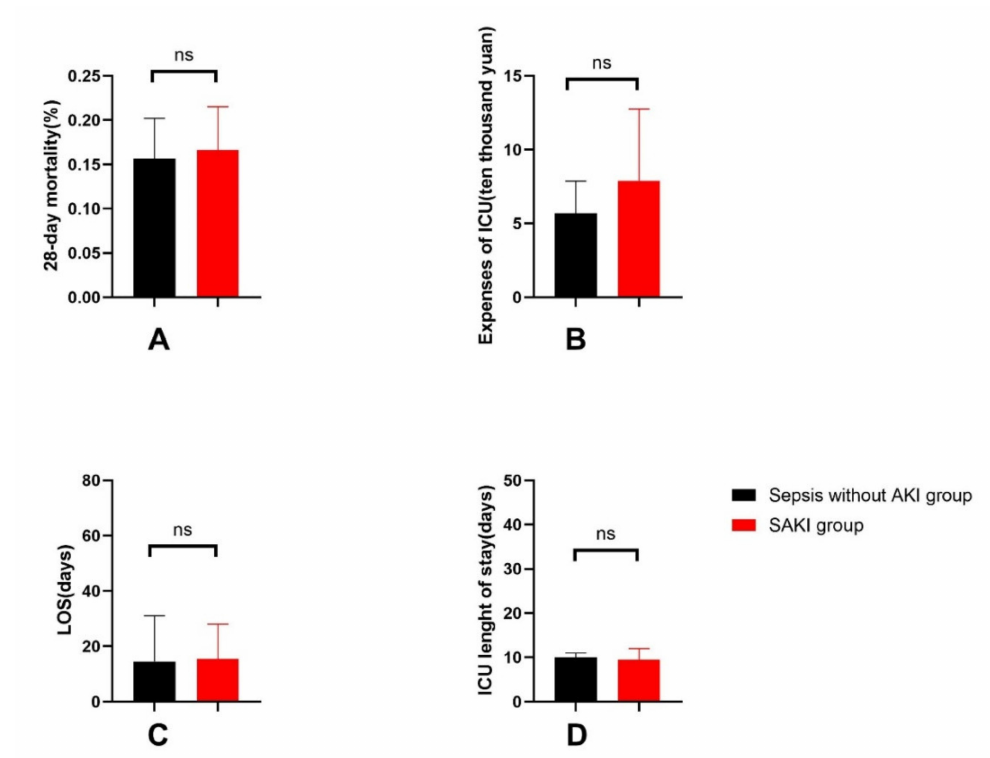
Figure 6. General outcomes between the SAKI group and the sepsis-without-AKI group, including the comparison of 28-day mortality ( A ), expenses of ICU ( B ), LOS ( C ), ICU length of stay ( D ). SAKI, sepsis-induced acute kidney injury; LOS, hospital length of stay; ICU, intensive care unit. p value: ns >